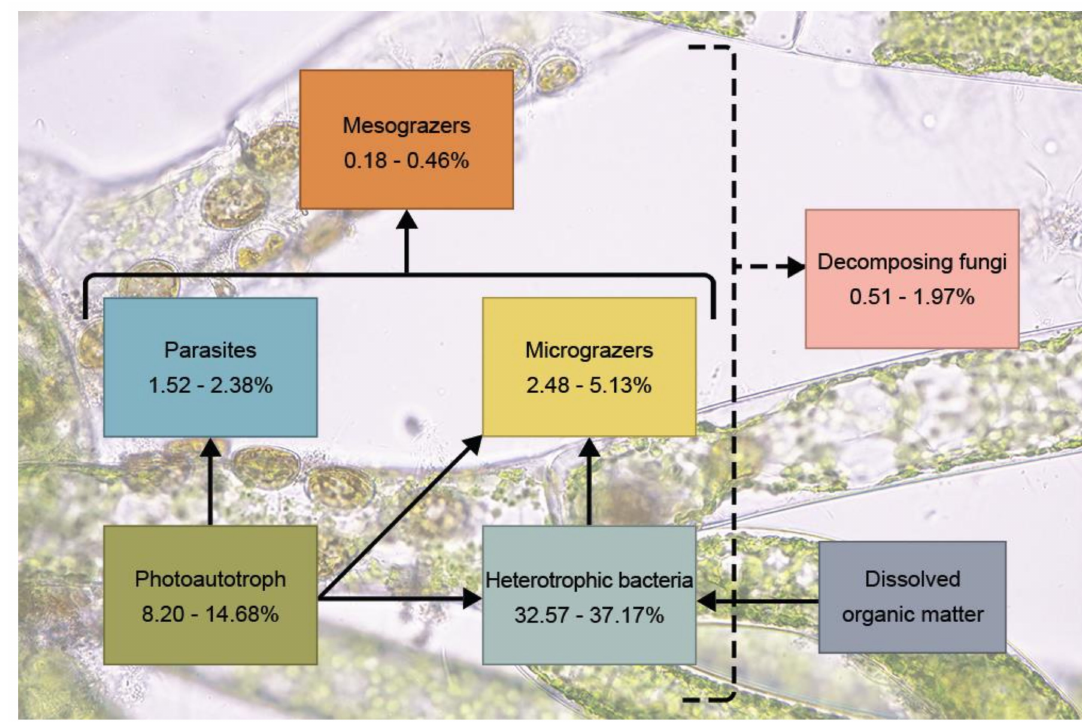
Figure 7. Average of the abundance of organisms living in the Cladophora microbiomes within each collecting site. For the identifiable taxa, the microbiomes were dominated by the heterotrophic bacteria, followed by photoautotrophs, micrograzers, parasites, decomposing fungi, and mesograzers.